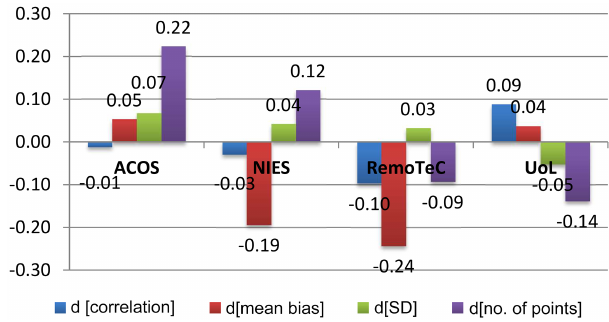
Figure 10. Difference (denoted as d [] ) in correlation coefficients, mean bias (ppm), SD (ppm) and number of observational points between methods C4 (the collocation domain size is determined by sensitivity values (ppm(µmol(m 2 s) − 1 ) − 1 ) with the limit of log 10 ( x ) equal to − 2.0) and C8 (the collocation domain size is rect- angular with dimension ± 7.5 ◦ ×± 22.5 ◦ ) using ACOS, NIES, Re- moTeC and UoL GOSAT products near the Reunion Island site. Please note scale of number of observational points is 10 4